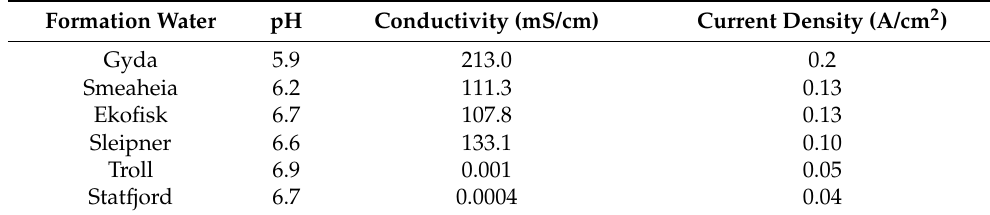
Table 2. Measured pH, conductivity and calculated current density of the different formation waters